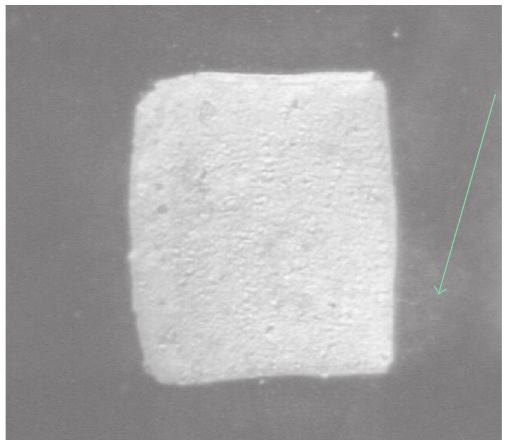
Figure 3: Collagen film surface after laser treatment ( F = 1 . 4 J/cm 2 , 3 pulses). Green arrow indicates a material deposition; black area represents nonirradiated region of the collagen